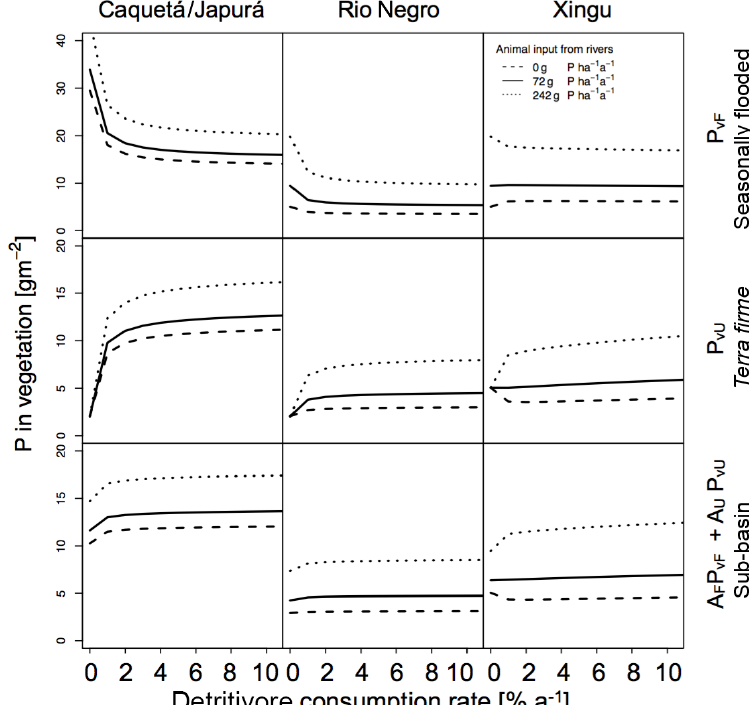
Figure 7. Sensitivities of detritivory on P in vegetation for the three sub-basins with different terrestrial piscivores P inputs. Effect of detritivory on P in vegetation (gPm − 2 ) for the three sub-basins (columns) with different terrestrial piscivores P inputs. P in vegetation is shown for seasonally flooded and terra firme ecosystems and on the sub-basin scale (rows). The different line types refer to different mechanisms of P input to the flooded ecosystem by terrestrial piscivores (none, otters only, otters and other species). Simulations were run without